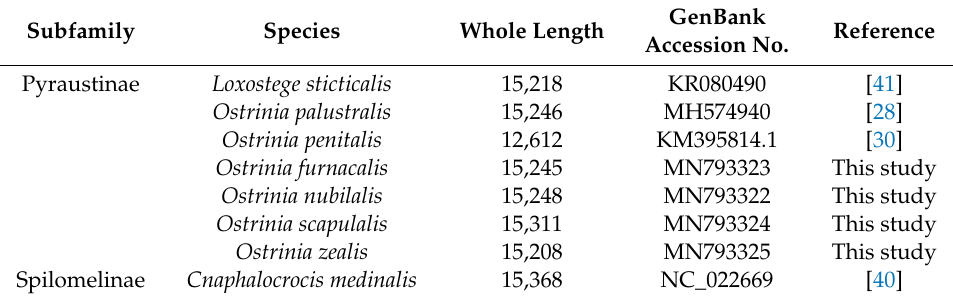
Table 1. The mitogenomic sequences used in this